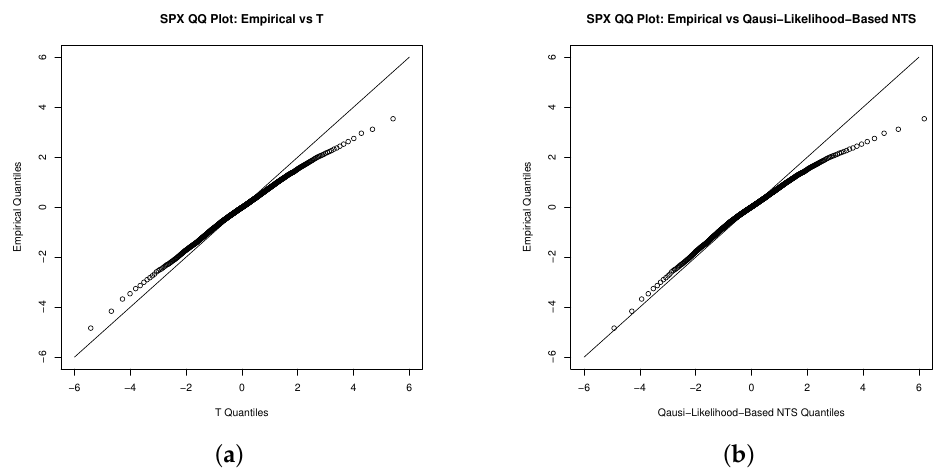
Figure 4. QQ plot for the innovations of the S&P 500 index with ( a ) the Student’s t and ( b ) NTS distribution.